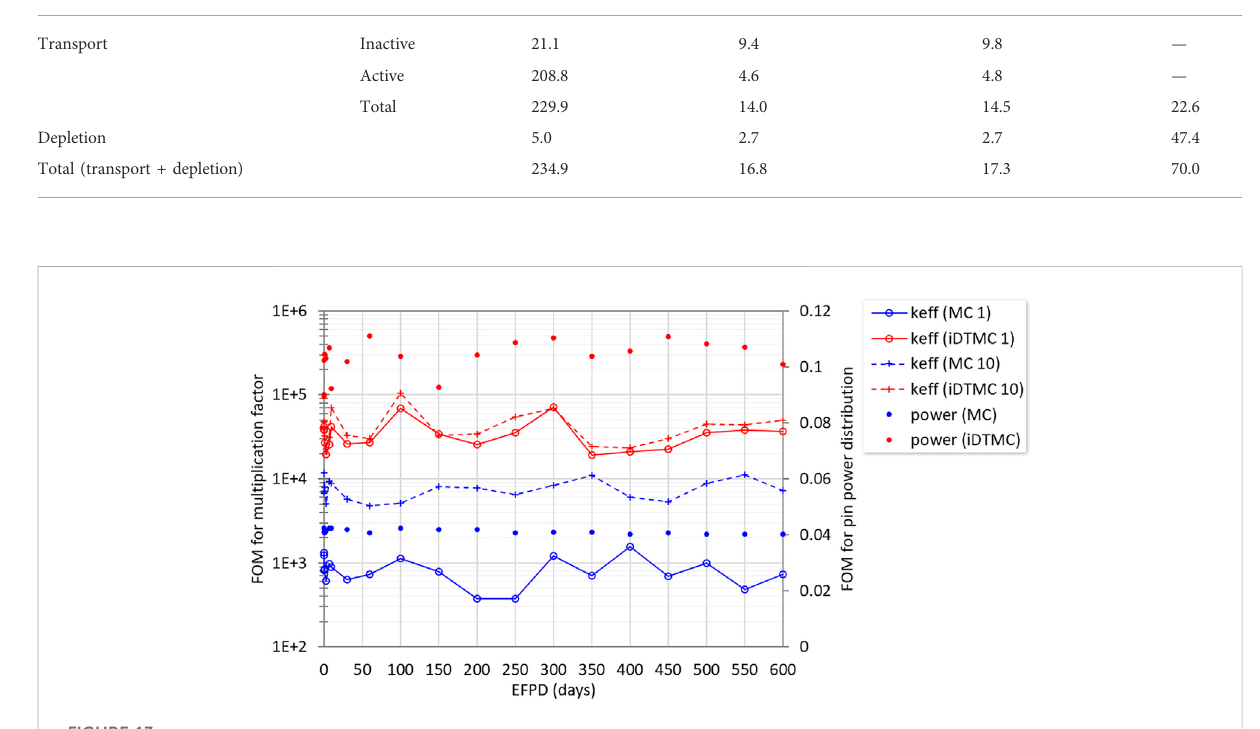
FIGURE 13 Figure of merits for the multiplication factor and pin power pro fi